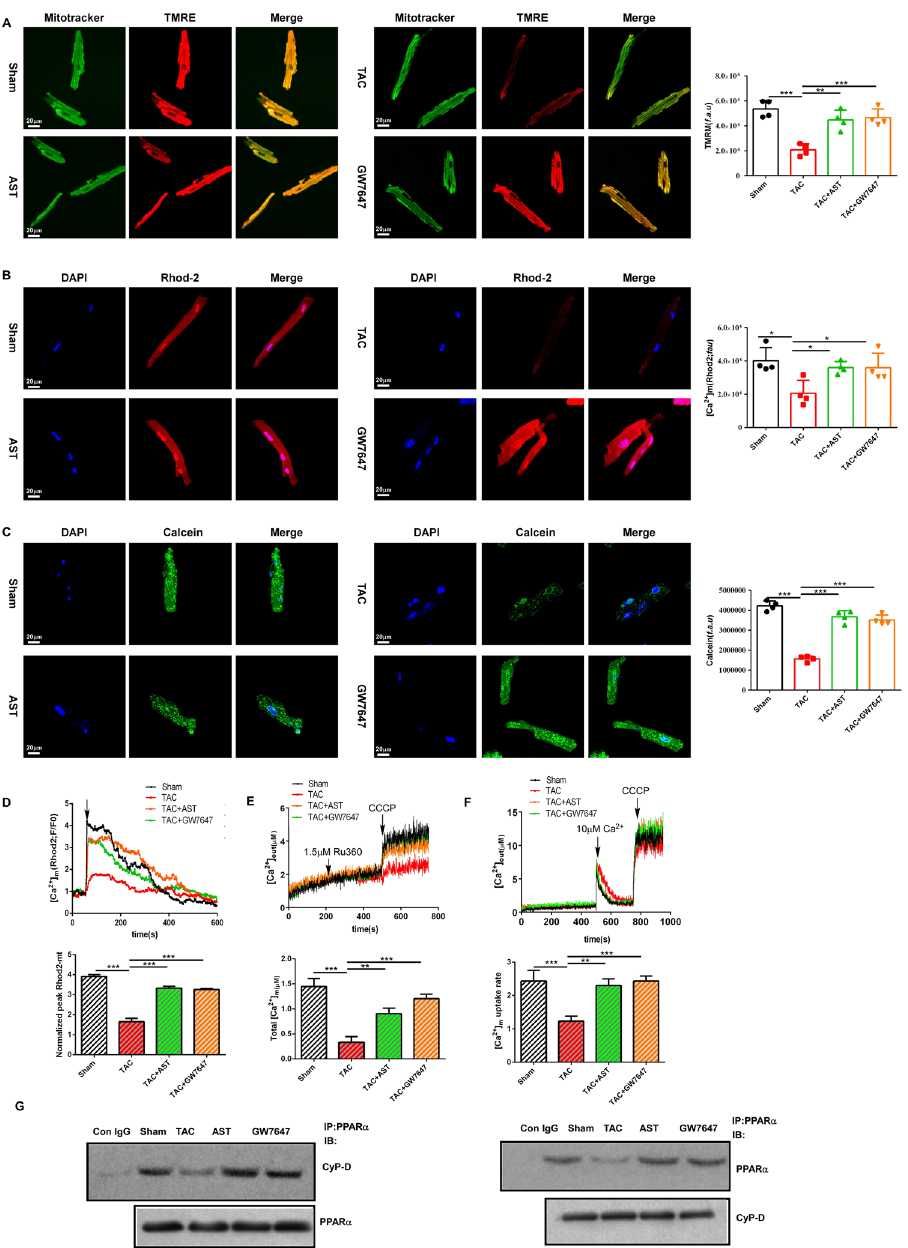
Figure 5. Astragaloside IV enhanced mitochondrial function in isolated myocardial cells. ( A ) Tetramethylrhodamine ethyl ester (TMRE) and Mitotracker double staining were performed to detect mitochondrial inner membrane permeability in isolated myocardial cells. The mitochondrial membrane potential was analysed using TMRE. The bar graph represents the mean ± s.d. of three independent experiments with ** P < 0.01 and *** P < 0.0001. ( B ) Rhod-2-specific mitochondrial localisation of Ca 2 + was determined using fluorescence microscopy. ( C ) Calcein staining of the opening of mitochondrial permeability transition pores was performed as described in the Methods section. The data represent three independent experiments with P < 0.05. Scale bars, 10 μ m. ( D ) The capacity for calcium uptake in isolate myocardial cells was determined from mitochondrial Ca 2 + (Rhod-2 AM) dynamics after stimulation with histamine (100 μ M). Data were assayed using confocal microscopy. ( E ) The isolated myocardial cells were permeabilised with 40 µ g/ml digitonin in 1.5 ml of intracellular medium along with thapsigargin, Ru360 and CGP37157. The accumulation of basal mitochondrial matrix Ca 2 + was determined using a multiwavelength excitation dual-wavelength emission fluorimeter (PTI). ( F ) The myocardial cells were pulsed with 20 μ M Ca 2 + and the mitochondrial Ca 2 + uptake rate was measured using the PTI. ** P < 0.01 and *** P < 0.0001 (n = 3). Data are mean ± s.d. ( G ) Cell lysis from each group were immunoprecipitated (IP) with anti-CypD, PPAR α . The original gels images are shown in Supplementary Fig. S6. ** P < 0.01 and *** P < 0.0001 (n = 3). Data are mean ±